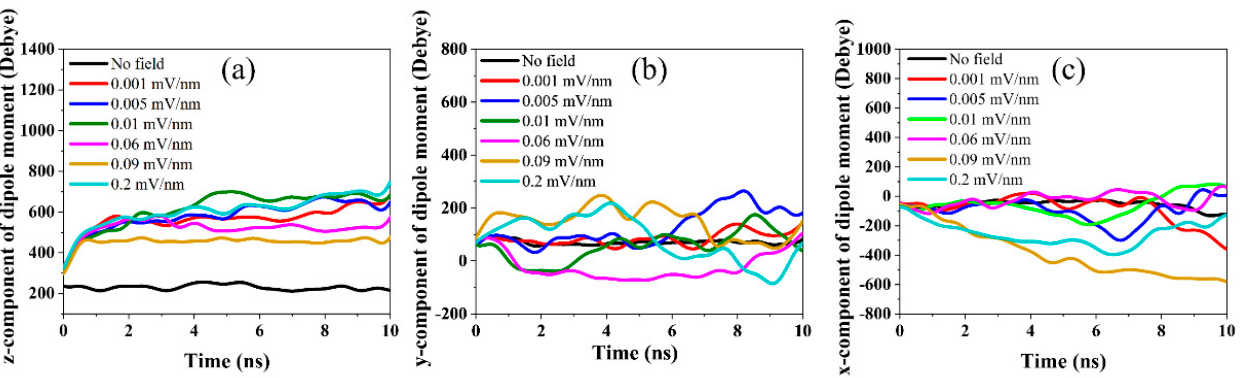
Figure 3. The ( a ) z-component, ( b ) y-component, and ( c ) x-component of the dipole moment of CNF exposed in the different electric field strengths along the z-direction.